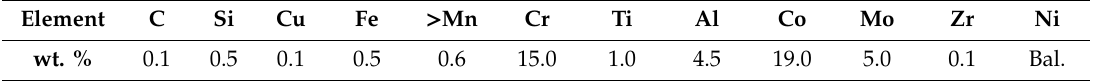
Table 1. Chemical composition of Nimonic-105 nickel-based superalloy.